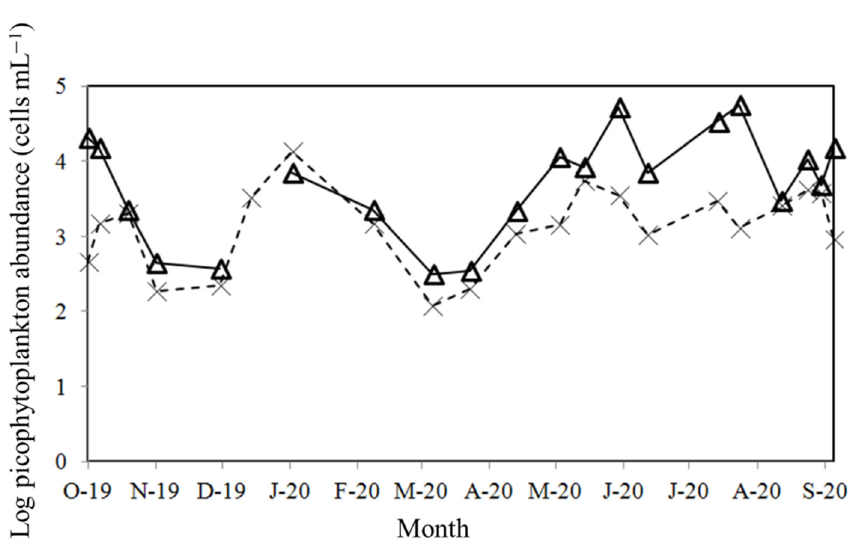
Figure 3. Seasonal variations of Synechococcus spp. ( ∆ ) and picoeukaryotic (X) abundance.